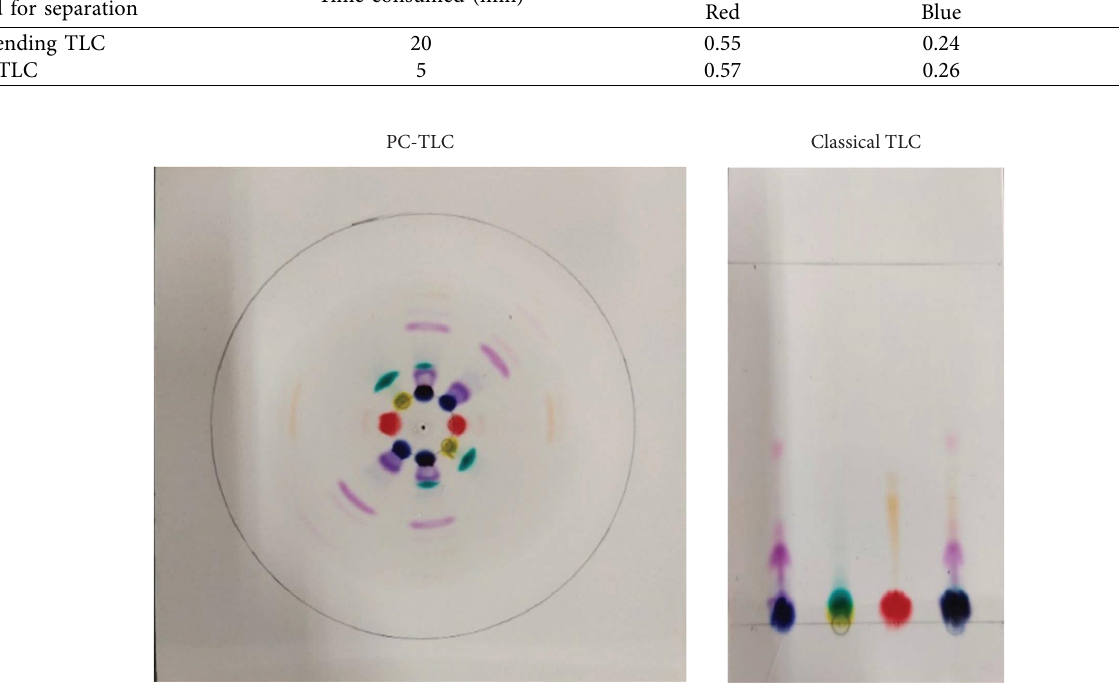
Figure 3: Fountain pen ink separation by classical and pressurized TLC.